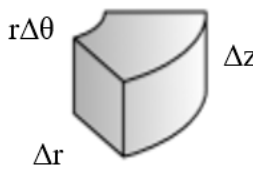
Figure 3. Cell used in the network model.